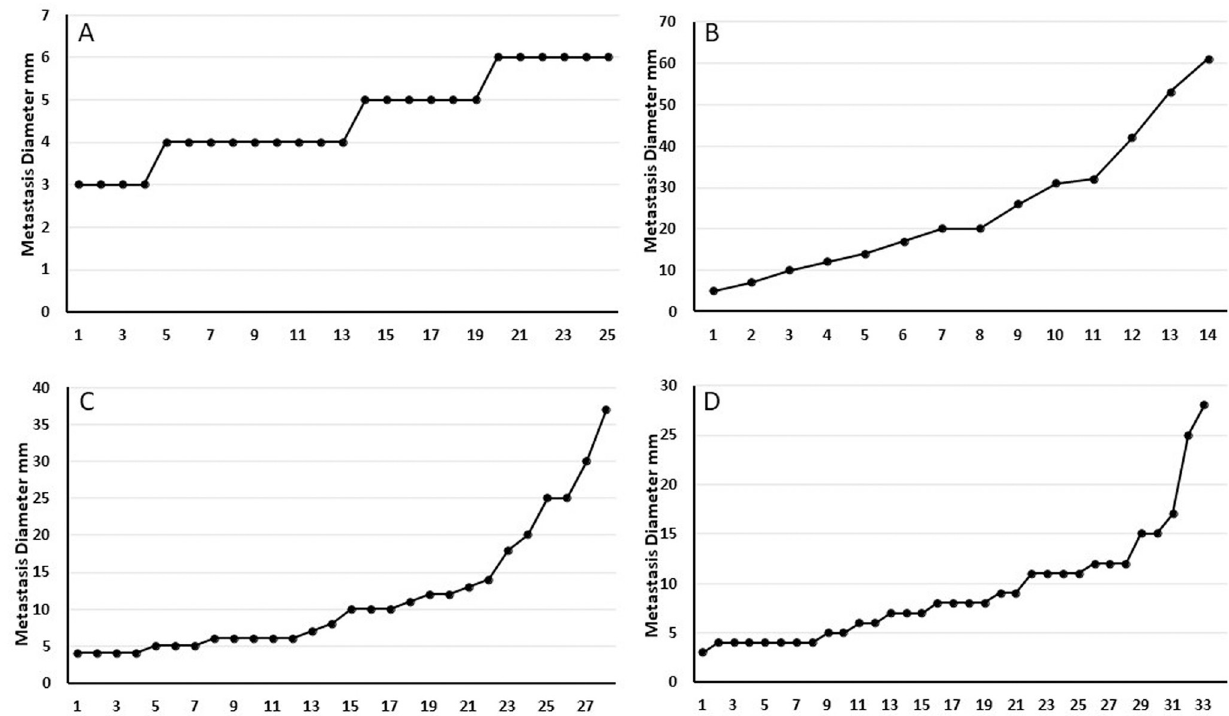
Fig 3. Examples of metastases diameter distribution in various diseases. A. an 82-year-old man with pancreatic tumor and 25 metastases. Four waves of metastases are seen LPR = 1. B. a 66-year-old man with leiomyosarcoma. Fourteen metastases are depicted with very limited similarity in diameters. LPR = -0.43. C. a 72-year-old man with colorectal carcinoma and 28 metastases. Some of the metastases can be clustered and some cannot, LPR = 0.57. D. a 72-year-old man with melanoma. Thirty-three metastases are depicted. Six to seven waves of metastases can be seen. LPR = 0.82.